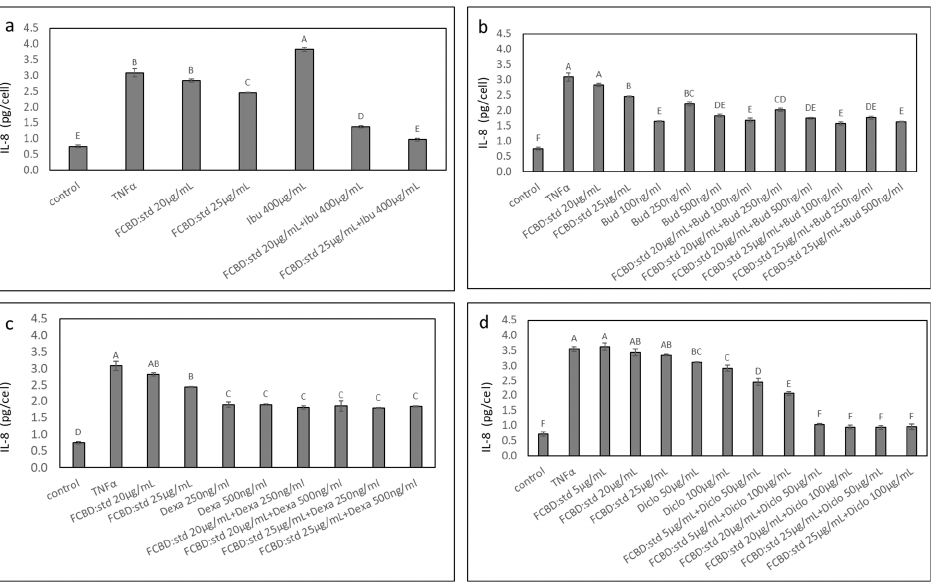
Figure 3. Effect of treatments with FCBD:std and ( a ) ibuprofen (Ibu), ( b ) budesonide (Bud), ( c ) dexamethasone (Dexa) or ( d ) diclofenac (Diclo) on IL-8 levels in co-cultures of A549 and differentiated KG1 cell lines. Control is vehicle control (1% methanol, 0.5% DMSO, 0.2% methanol + 0.5% DMSO and 1% DMSO for Ibu, Bud, Dexa and Diclo, respectively). TNFα is solvent control + TNFα. Means ± SE ( n = 3) are shown. Levels of means with different letters are significantly different from all pairs’ combinations according to Tukey–Kramer honest significant difference (HSD; p ≤ 0.05).